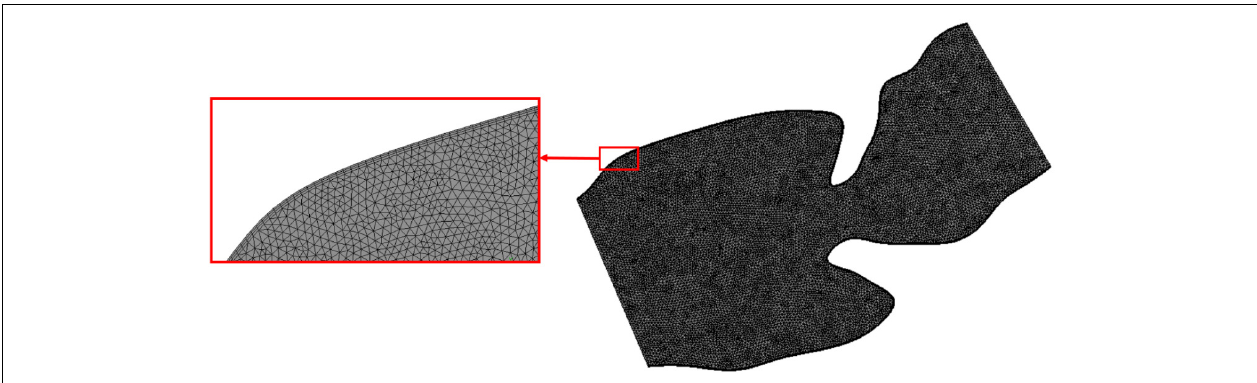
FIGURE 7 | The mesh with moderate density for the sectioned control 1 heart at week 24. Mesh density is increased on the wall boundaries as shown in the red box for improving the solution accuracy.